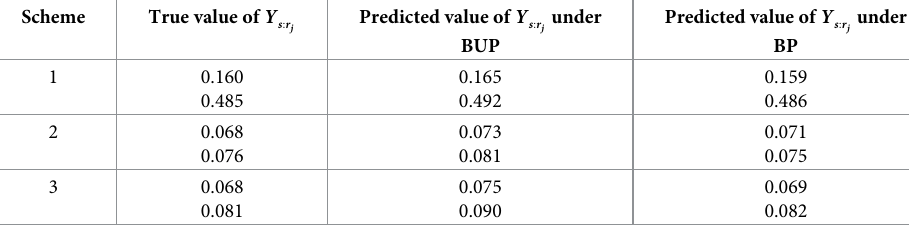
Table 3. True and predicted observations under censoring scheme 1, 2, and 3.